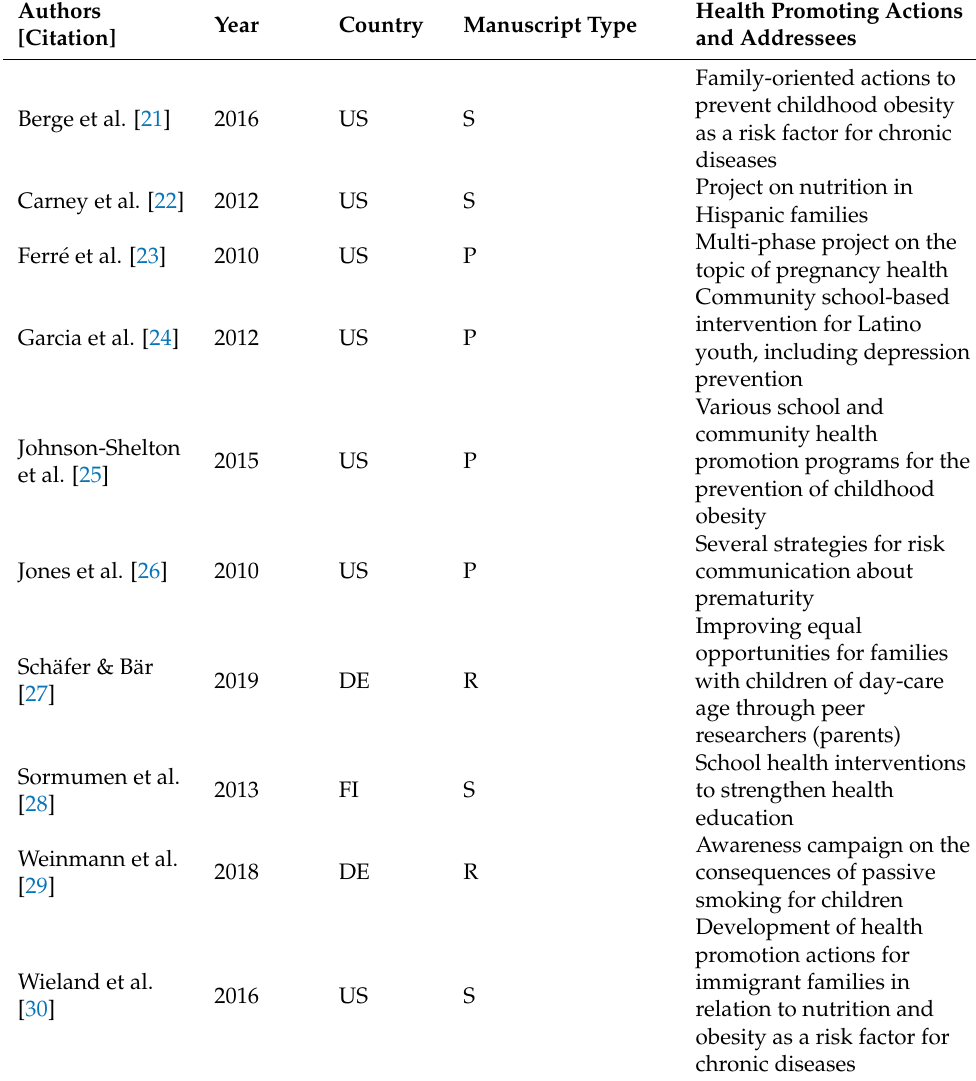
Table 1. Overview of included